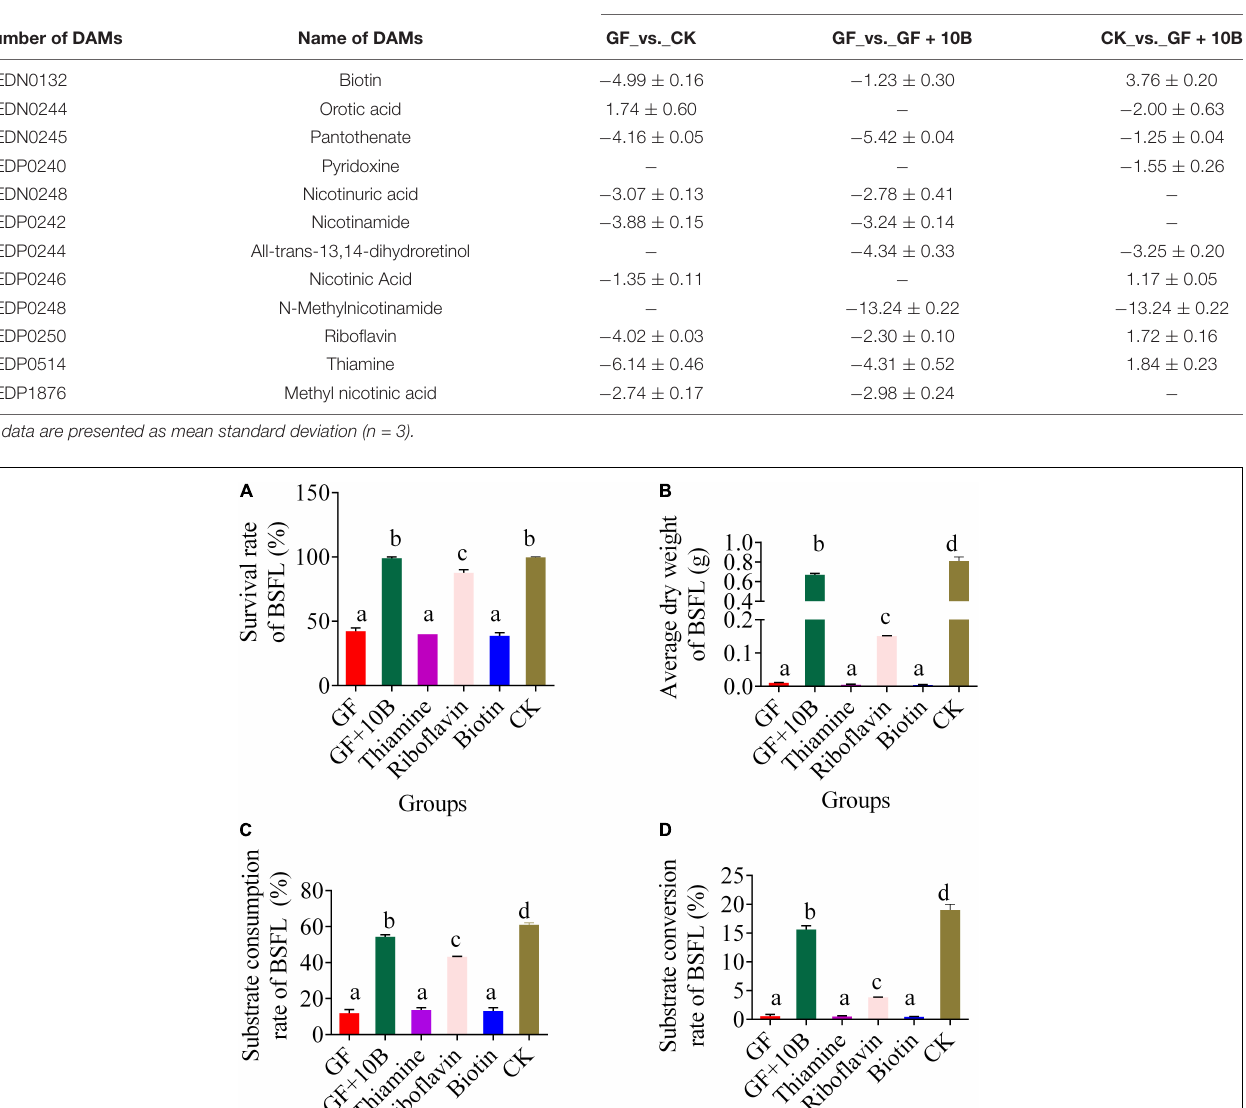
TABLE 2 | Functional analyses of identified differentially accumulated metabolites related to vitamins. Number of DAMs Name of DAMs